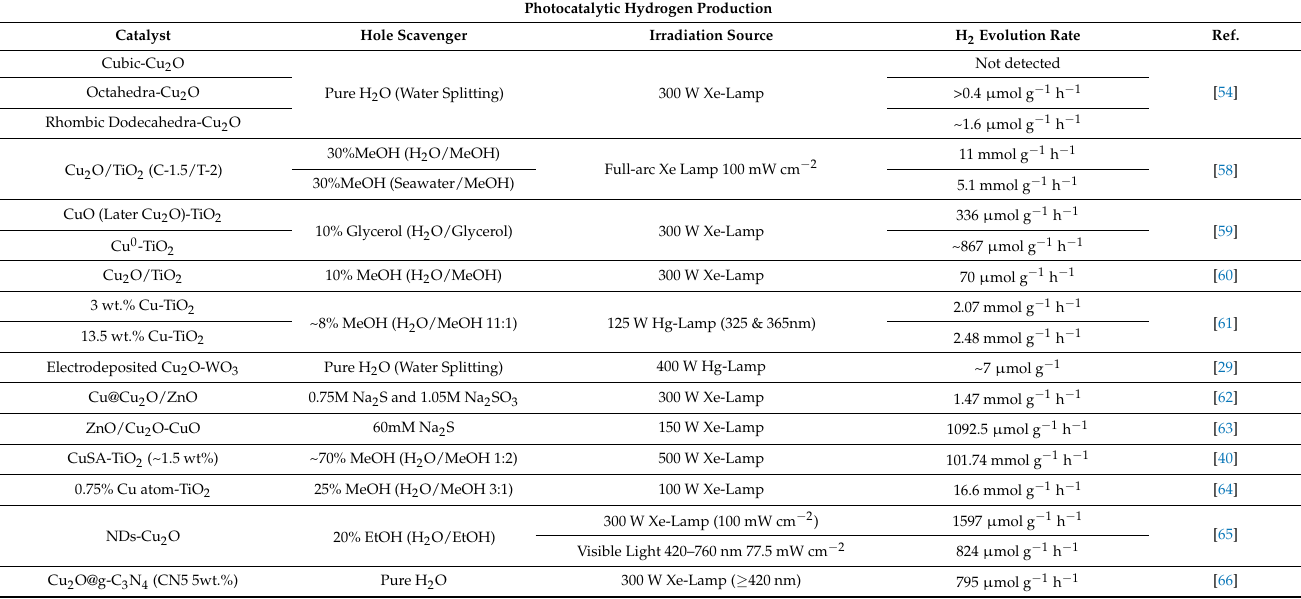
Table 2. Summary of pertinent Cu-based heterojunctions and photocatalytic H 2 evolution rates.